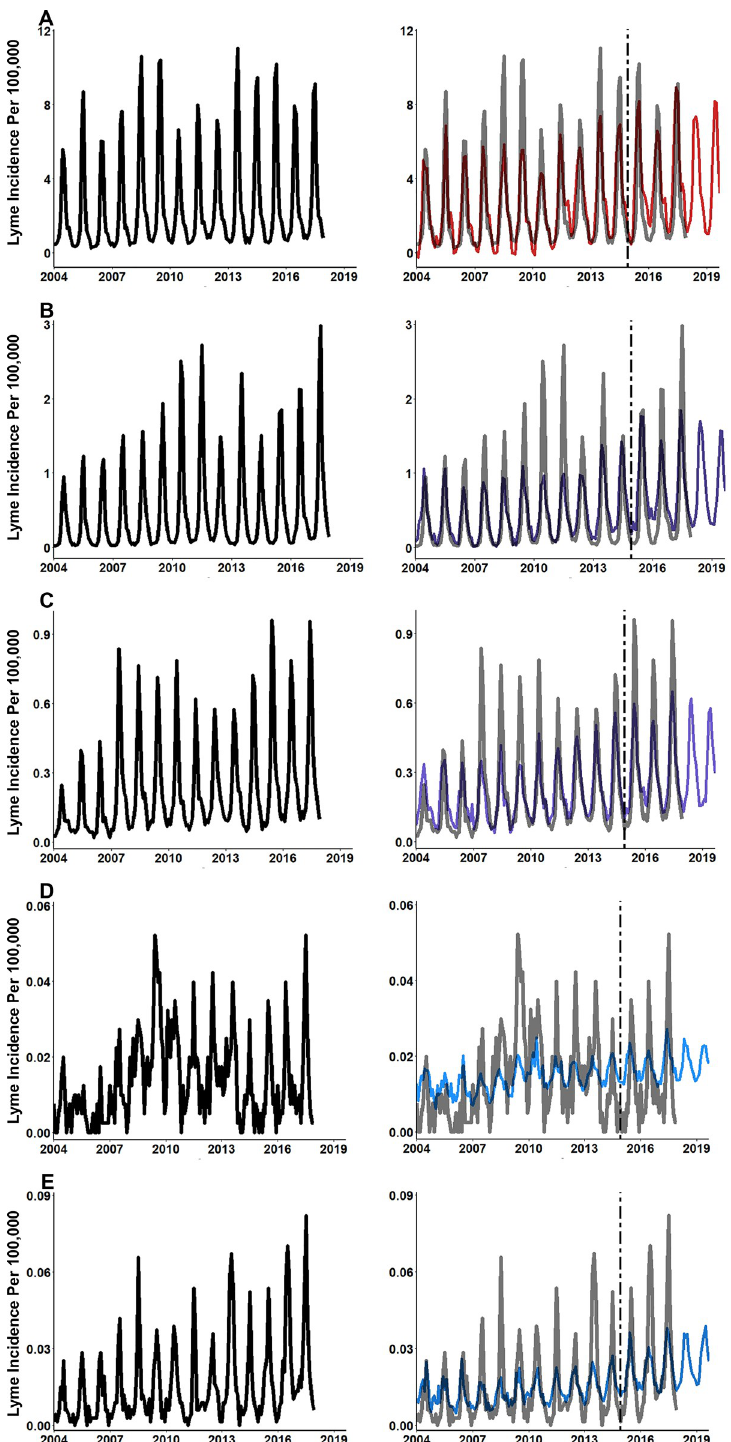
Fig 5. Elastic net modeling using disease symptom and vector terms only produces accurate nowcasting model for Lyme disease. (A) Northeast, (B) Midwest, (C) Southeast, (D) Southwest, and (E) West. Same one-year period from Northeast region with accurate nowcast model. Two elastic net models were developed for each region. Elastic net models trained using CDC surveillance data and search term data from February 2004 through December 2014. Vertical dashed line starts at January 2015 and indicates the start of the hold-out data set. Nowcasting performed using search term data from January 2018 until September 2019. https://doi.org/10.1371/journal.pone.0251165.g005 PLOS ONE | https://doi.org/10.1371/journal.pone.0251165 March 10,